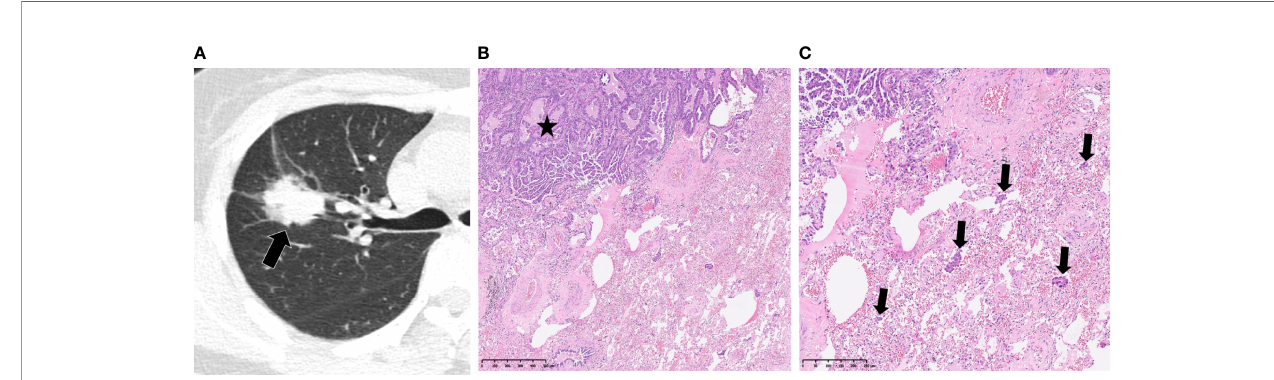
FIGURE 3 | Spread through air spaces in a 52-year-old woman with papillary adenocarcinoma. (A) Axial CT image presenting a slightly lobulated, solid tumor in the right upper lobe (arrow). (B, C) Photomicrographs showing detached papillary clusters of tumor cells (arrows) in the alveolar space beyond the edge of the main tumor (*). Hematoxylin-eosin staining, magni fi cation x50 (B) , x100 (C) .